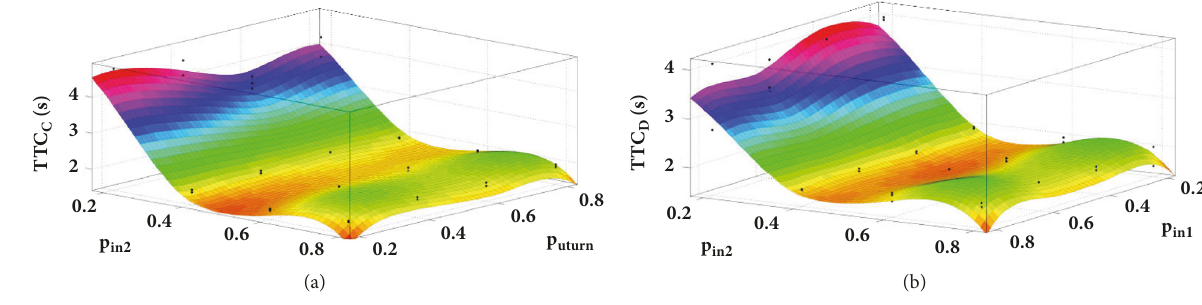
Figure 7: Impact of factors on TTC in lane. (a) Lane C. (b) Lane D.